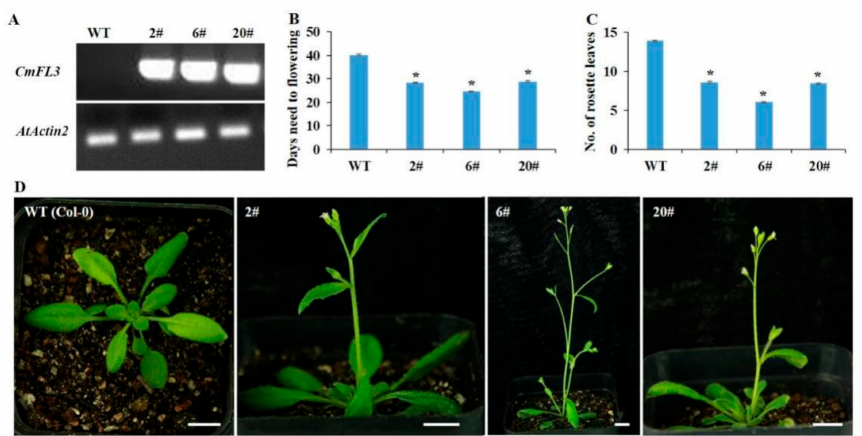
Figure 7. Phenotypic observation of the WT and CmFL3 -overexpressing transgenic Arabidopsis plants. ( A ) The abundance of CmFL3 in the transgenic and WT plants. ( B ) The number of days to